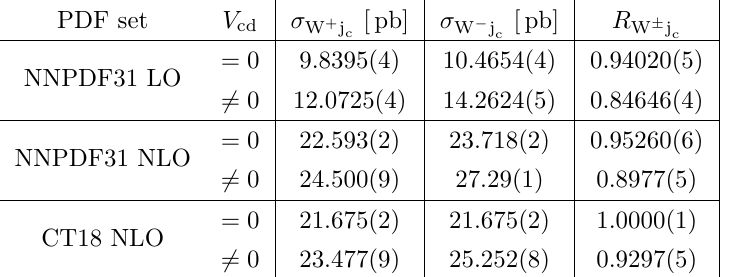
Table 3. LO fiducial cross sections for pp → W + j √ s = 7 TeV for different PDF sets. Predictions for both V cd = 0 and V cd 6 = 0 are given. The digit in parenthesis indicates the Monte Carlo statistical